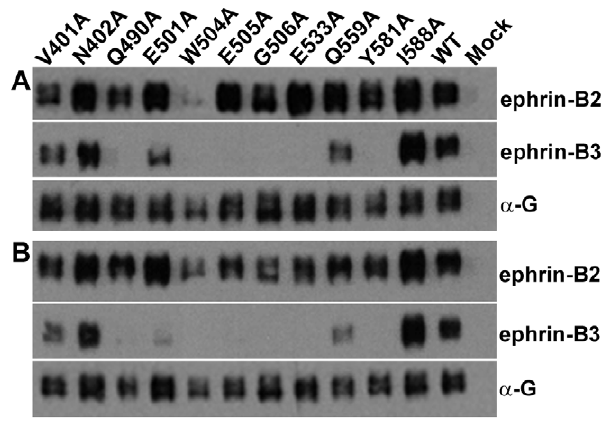
Figure 8. Effect of structure-based HeV-G mutations on viral entry. Luciferase-encoding HIV-1 based pseudovirus stocks were prepared in 293T cells using wild-type (WT) or alanine substitution mutants of HeV-G with the HeV-F by expression plasmid transfection together with pNL4-3-Luc-E - R + as described in Methods . Each pseudo- virus stock preparation was analyzed by p24 quantification and equal amounts of virus particles were used to infect target cells, either Hela- USU cells expressing ephrin-B2 (A) or ephrin-B3 (B), and performed in triplicate. Cells were incubated for 48 hr following infection and processed for luciferase activity quantification using a Centro LB 960 Microplate Luminometer (Berthold Technologies). This experiment was repeated six times and a representative experiment is shown. (C) Incorporation of the HeV F and wild-type and mutant G glycoproteins into pseudovirus particles was assessed by Western blot of lysates reactive polyclonal mouse antiserum to HeV G and HeV F was detected with a rabbit polyclonal F1 specific antiserum as described in the Methods.